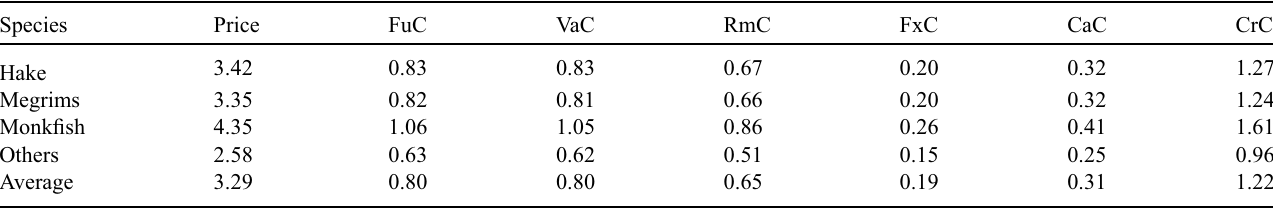
Table A.6. Price and cost structure (fuel costs (FuC), other variable costs (VaC), crew costs (CrC), repair and maintenance costs (RmC), fi xed costs (FxC), capital costs (CaC)) of main species exploited in the HMM fi shery (hake, monk fi sh, megrim) by the polyvalent general þ 18m fl eet segment in 2019.